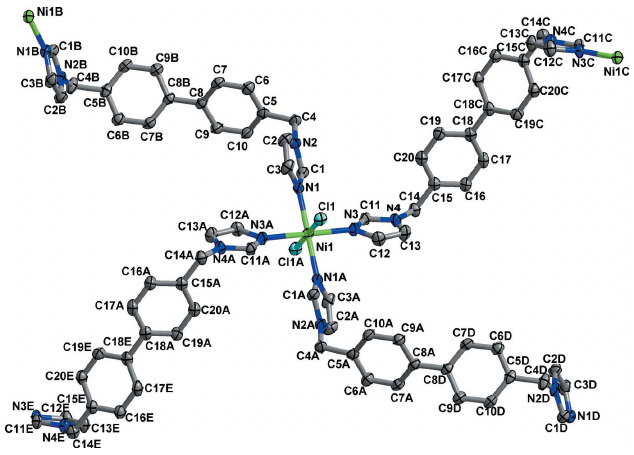
Figure 1 The coordination environment of the zinc ions and the BIMB ligands in the title compound, with displacement ellipsoids drawn at the 30% probability level. H atoms are omitted for clarity. [Symmetry codes: (A)